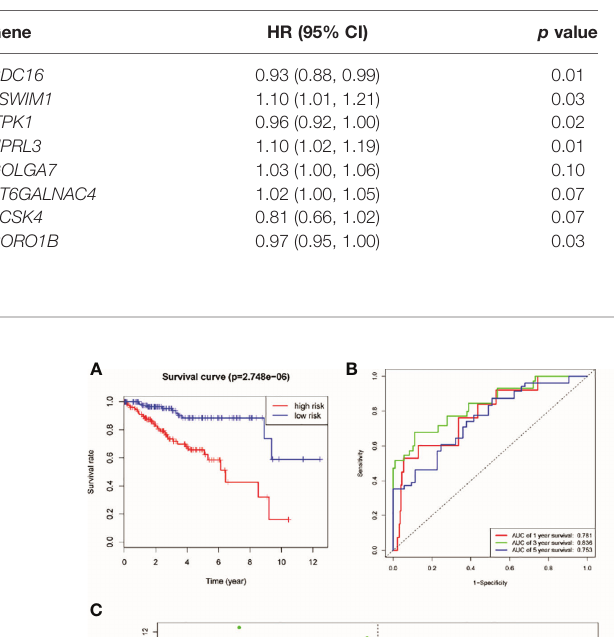
TABLE 1 | Multivariate Cox regression eight genes weighted by their relative coef fi cient.